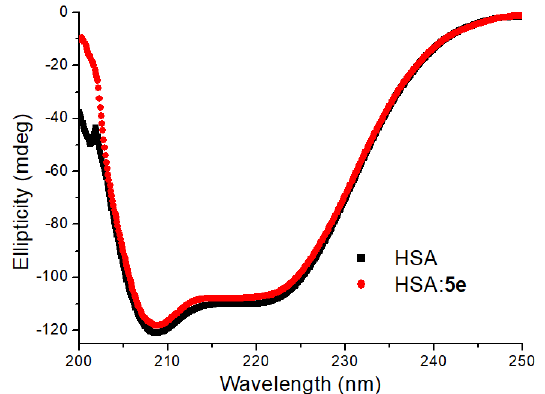
Figure 7. CD spectra for HSA without and in the presence of 5e at 310K and pH = 7.4. [HSA] = 1.00 × 10 −5 M and [ 5e ] = 2.78 × 10 −5 M.